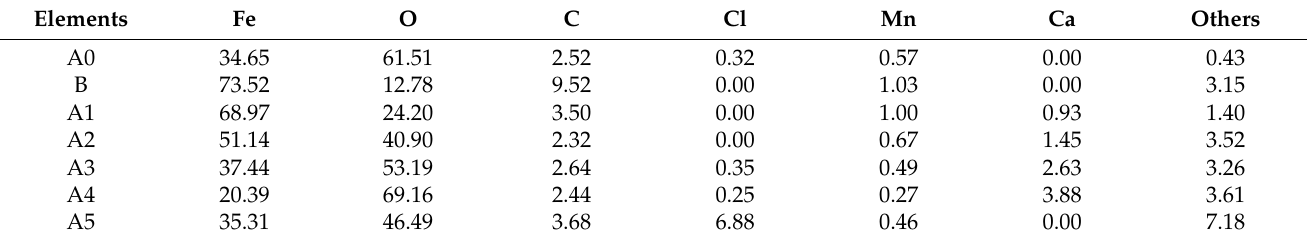
Figure 5. Potentiodynamic polarization curves of specimens coated with MCIs after different degrees of chloride erosion. Table 4. Elemental content on the steel bar surfaces, as obtained by EDS (at.